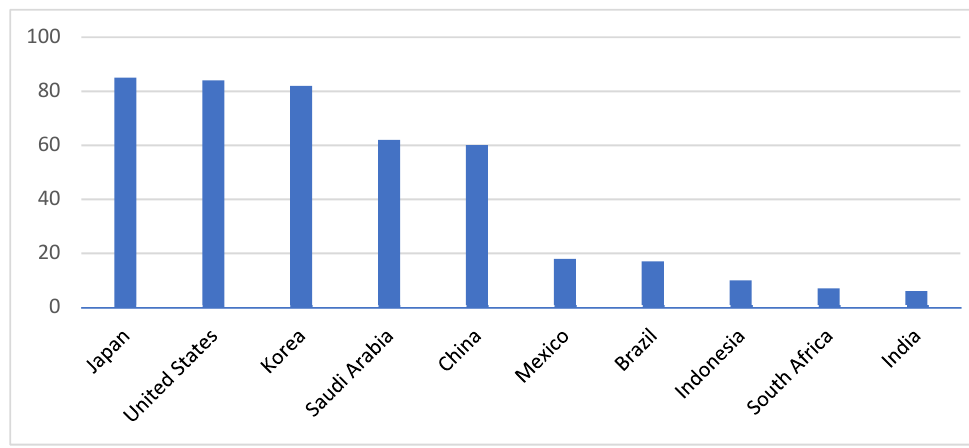
Figure 1. Percentage of households equipped with AC units in selected countries, 2018 [4].